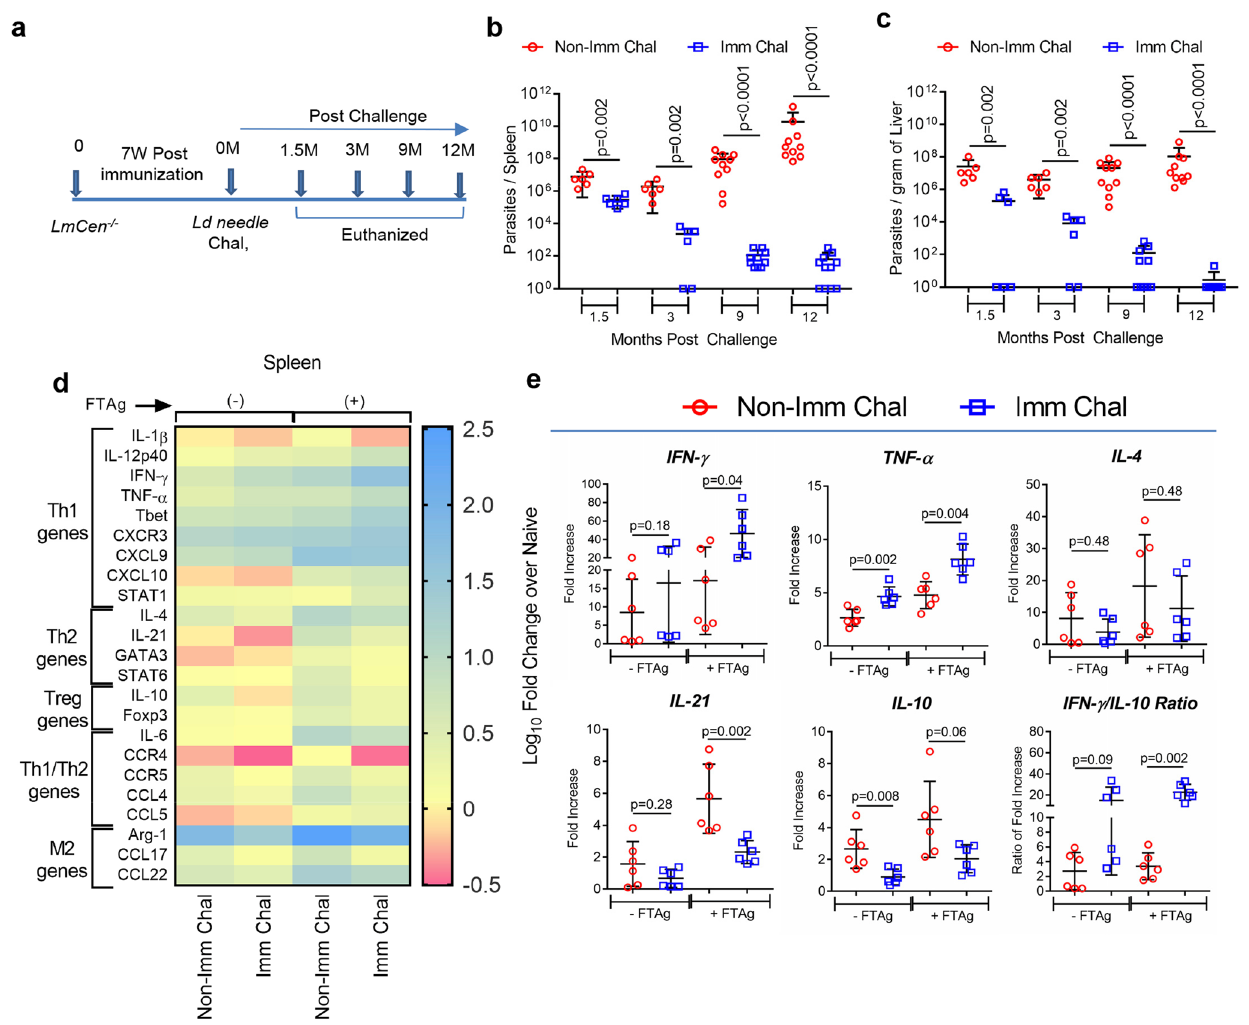
Fig. 3 LmCen − / − immunized hamster protects and induces pro-in fl ammatory type of immune response upon challenge with L. donovani . a Schematic representation of experimental plan to determine the ef fi cacy and immune response of LmCen − / − parasites hamsters against L. donovani via needle challenge. b , c Parasite load were determined by limiting dilution after various periods post challenge and expressed as number of parasites per Spleen ( b ) and per gram of Liver ( c ). LmCen − / − immunized (Imm Chal) ( n = 6 for 1.5 and 3 months and n = 10 for 9 and n = 11 for 12 months) and age-matched nonimmunized (Non-Imm Chal) hamsters ( n = 6 for 1.5 and 3 months and n = 10 for 9 and 12 months) after various periods of post-needle challenge (1.5, 3, 9, and 12 month) with L. donovani . Results (Mean ± SD) are representative of cumulative effect of two independent experiments ( p values were determined by Mann – Whitney two-tailed test). d Heat map showing the differential gene expression in the splenocytes (with or without 24 h of L. donovani freeze – thaw antigen restimulation; ±FTAg) of age-matched nonimmunized (Non-Imm Chal) and LmCen − / − immunized (Imm Chal) hamsters after 1.5 months of L. donovani challenge by needle injection ( n = 6/group). According to the general function, transcripts are annotated in the left side. Downregulation and upregulation of the transcripts are shown in pink, yellow and blue, respectively. For heat map, results were shown as log 10 fold change over naive hamster. e Expression pro fi le of IFN- γ , TNF- α , IL-4, IL-21, IL-10, and IFN- γ /IL-10 Ratio in the spleen, which was evaluated by RT-PCR. The data were normalized to γ -Actin expression and shown as the fold-change relative to age-matched naive hamster. Results (Mean ± SD) represent cumulative effect of two independent experiments ( p values were determined by Mann – Whitney two-tailed